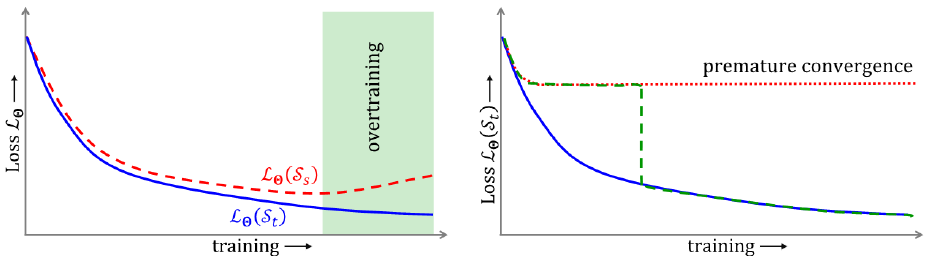
Figure 3. Overtraining and premature convergence. Overtraining is illustrated ( left ), showing how test loss (dashed red) begins to rise with overtraining (shaded green region) although training loss (solid blue) decreases. Premature convergence ( right ) of the training loss is shown (dotted red) in contrast to desired convergence (dashed green, solid blue). Due to “V” shaped narrow ridges in the loss function’s landscape, there may not be any perceptible decrease in the loss for many training iterations (dashed